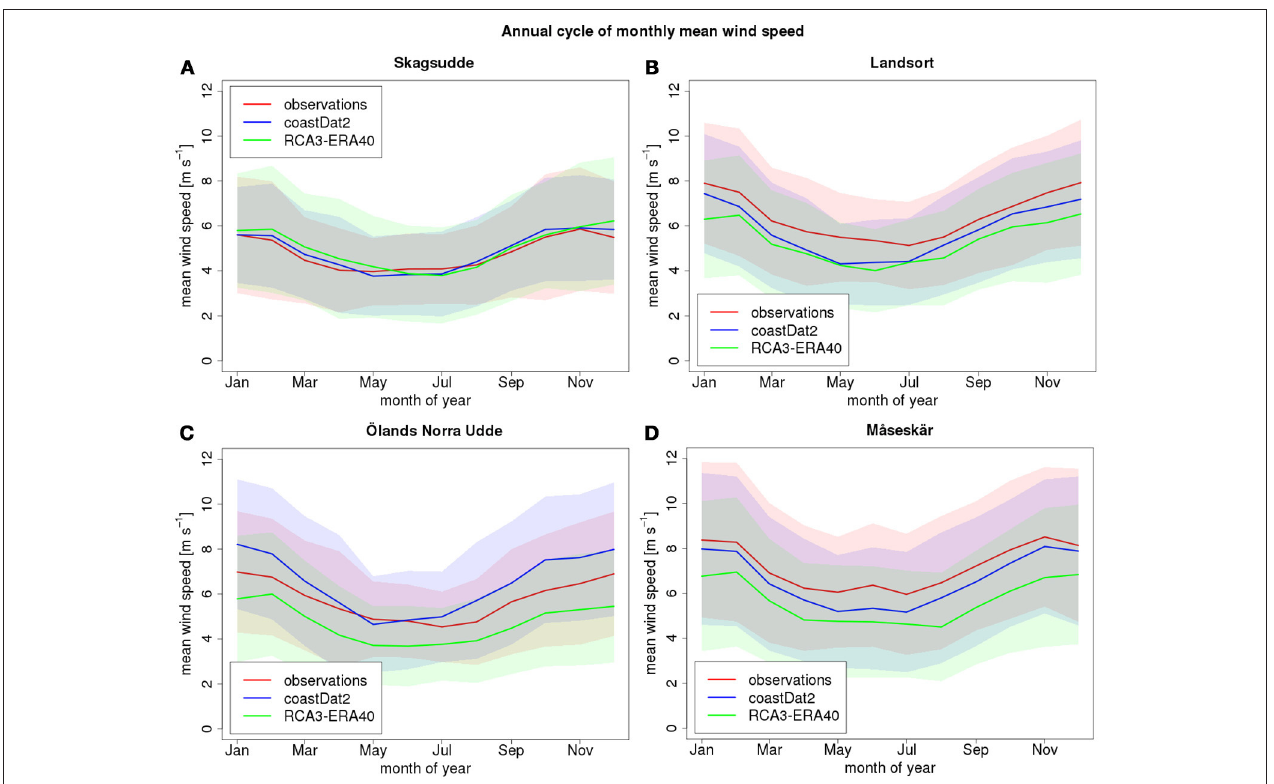
FIGURE 12 | Annual cycle of monthly mean wind speed at selected stations around the Baltic Sea for the observations (red), coastDat2 (blue), and RCA3-ERA40 (green): (A) Skagsudde, (B) Landsort, (C) Ölands Norra Udde, and (D) Måseskär. The solid lines indicate the monthly mean and the shading indicates ± 1 standard